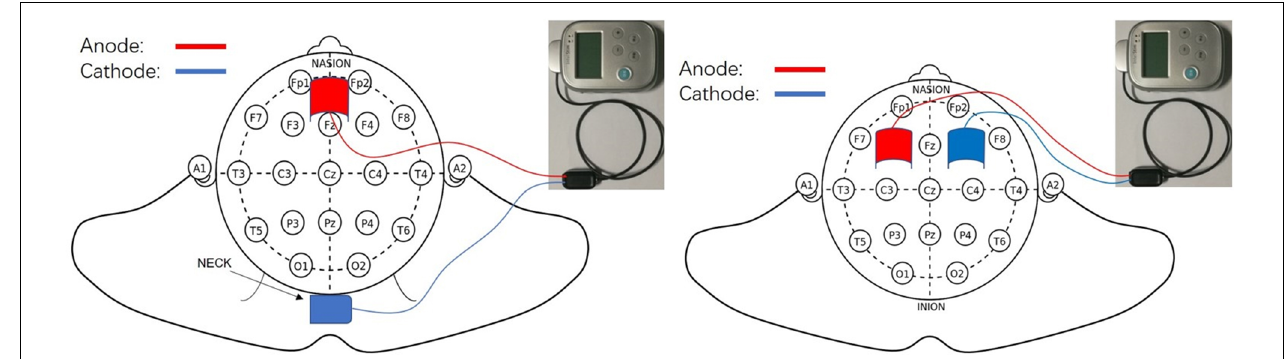
FIGURE 1 | Transcranial direct current stimulation electrode